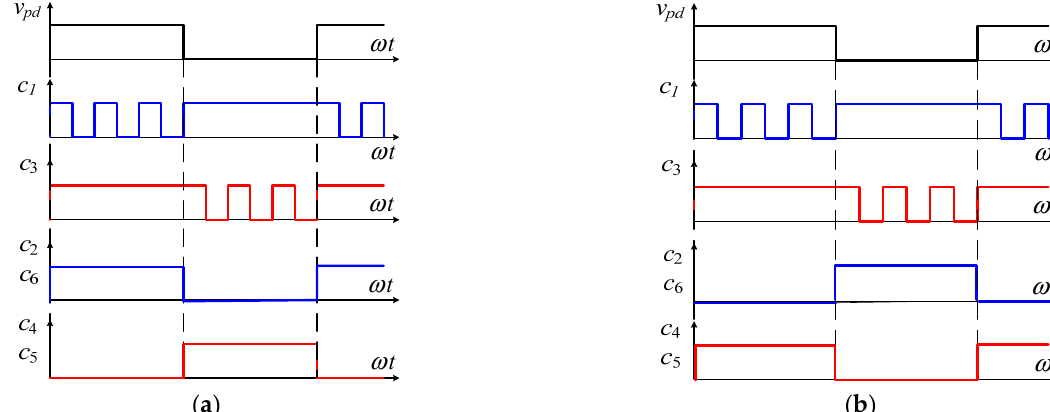
Figure 3. Generation of control signals with respect to input voltage polarity detector for voltage buck to achieve ( a ) non- inverted form of output and ( b ) inverted form of output.